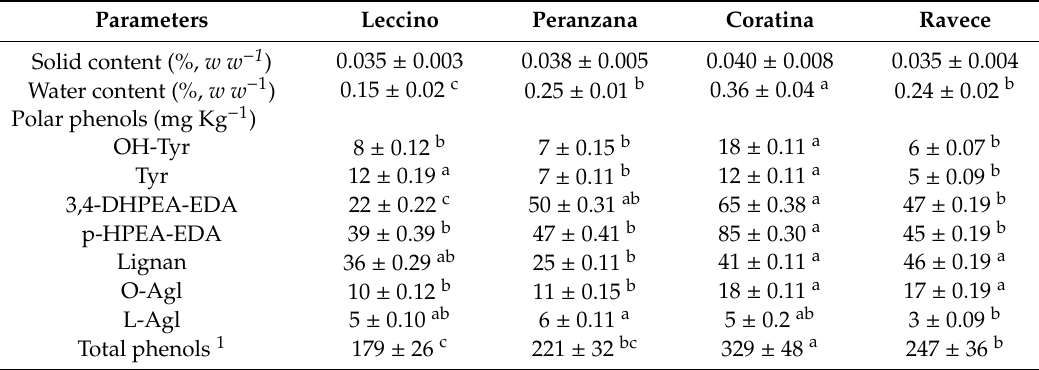
Table 2. Physico-chemical characteristics of the monovarietal extra virgin olive oils (EVOOs) used in the blending